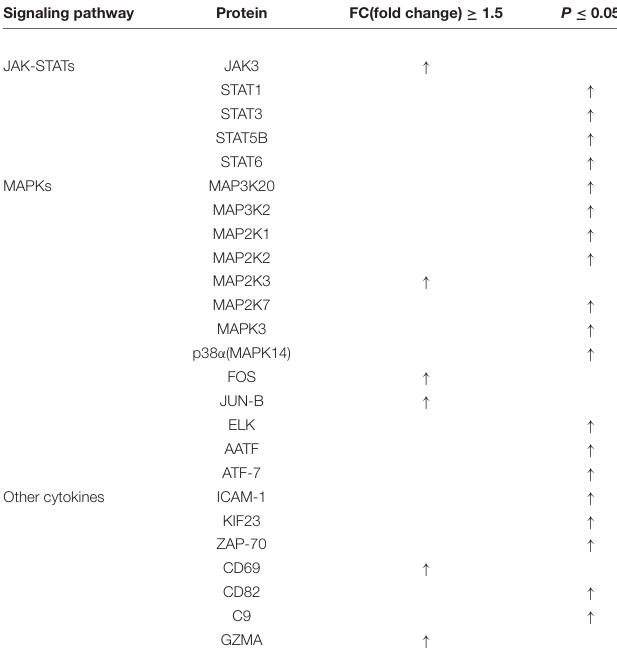
TABLE 1 | Upregulated cell activation related proteins in FIP-fve -induced Jurkat E6-1 cells. Signaling pathway Protein FC(fold change) ≥ 1.5 P ≤ 0.05